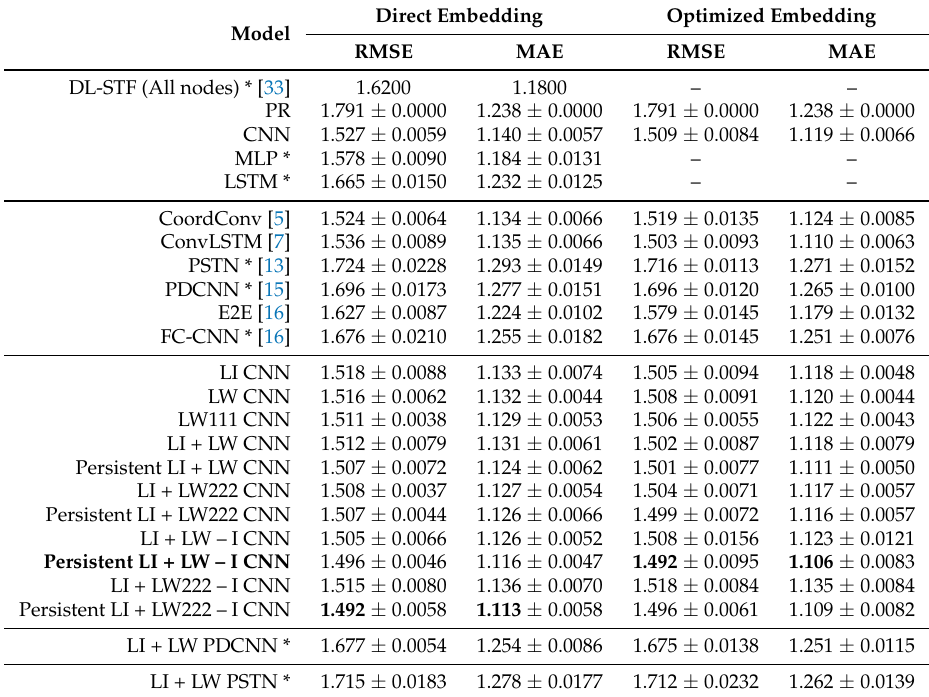
Table 3. Results on METAR data embedded on a regular grid, the direct and optimized embeddings. Models that disregard spatial relations are reported “–” results in the second, as they would be identical. Models that have no natural spatially-ordered output are marked with “*”. deviation. Best results are highlighted in